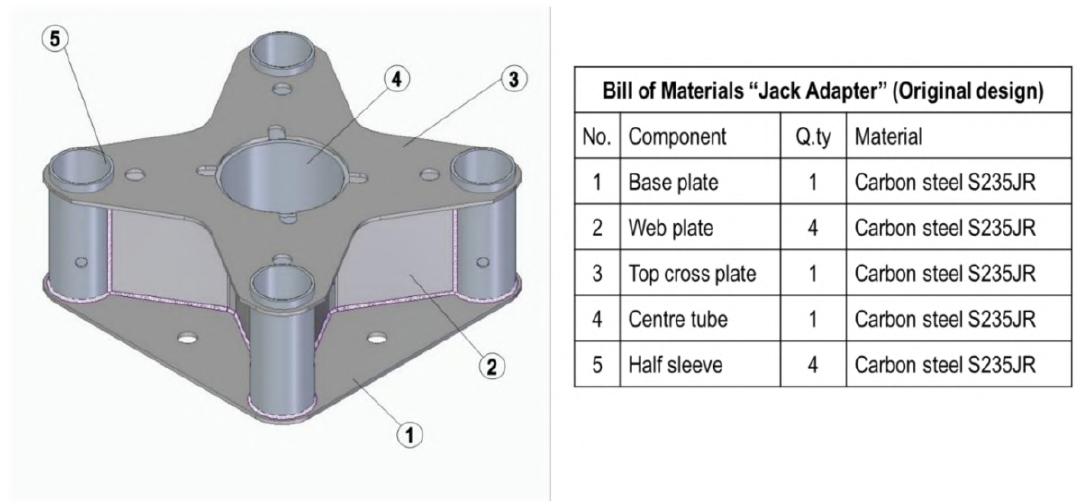
Figure 7. CAD model of the first sub-assembly (jack